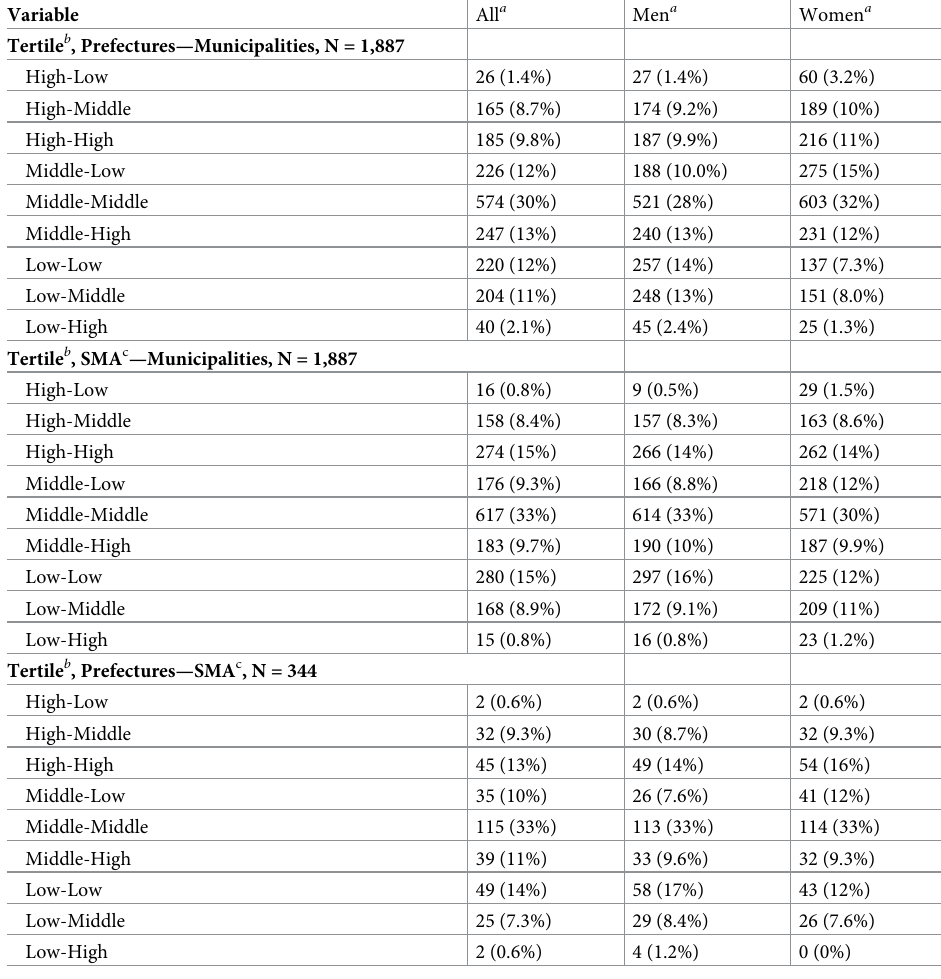
Table 3. Comparison of tertile by